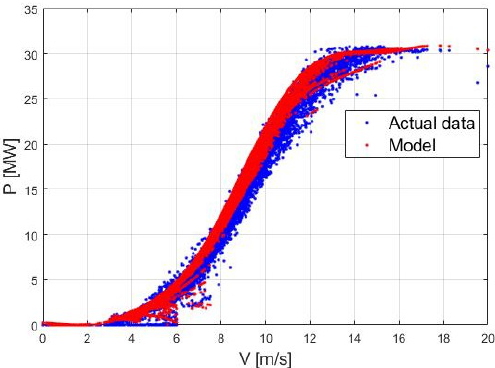
Figure 23. Data as measured and forecast of energy production from wind power plant FW3.